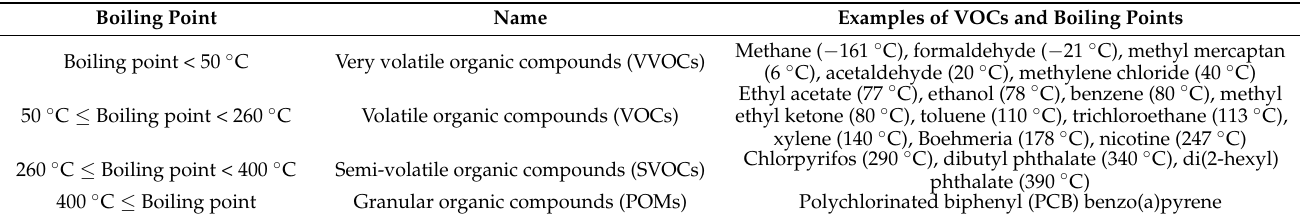
Figure 1. The classification of different VOCs [2]. Table 1. The VOCs are classified by boiling point according to WHO.